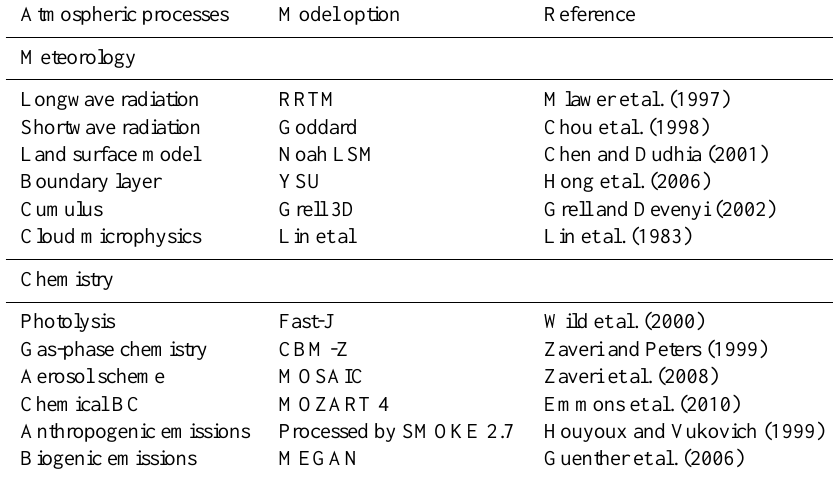
Table 1. The WRF/Chem configuration options used in this study.